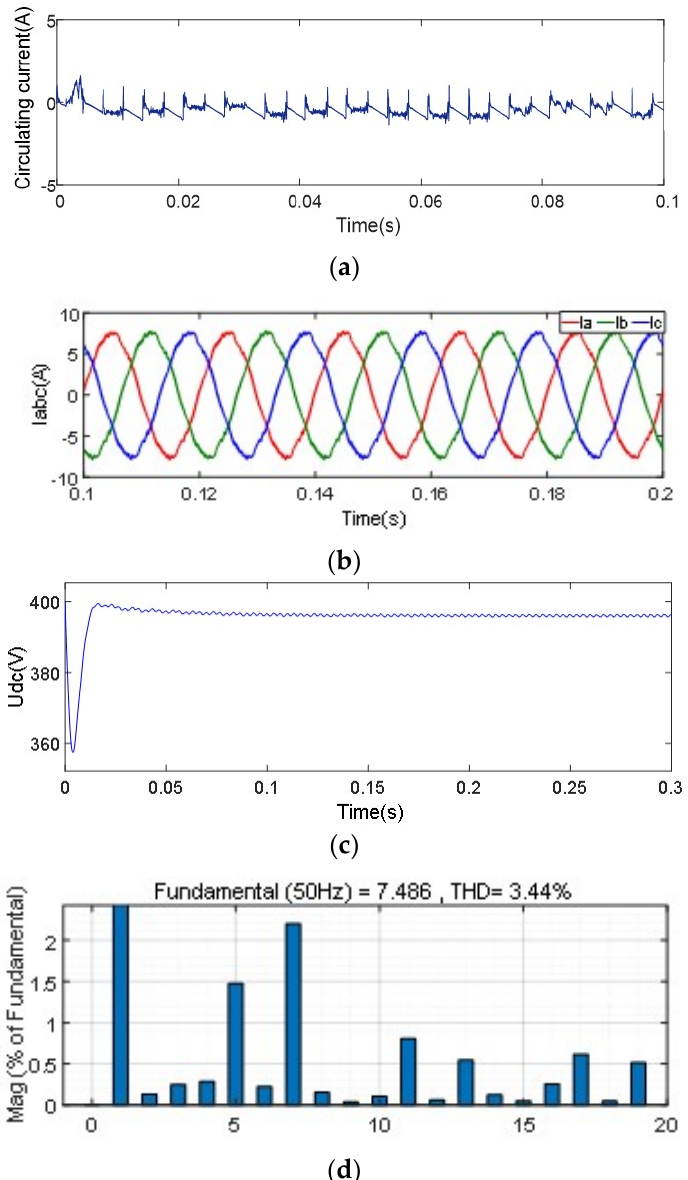
Figure 10. Adding a control scheme of suppressing circulating current under different conditions of DC-side inductance parameters ( a ) Positive DC bus circulating current. ( b ) AC side current. ( c ) DC side output voltage. ( d ) THD of AC side current.